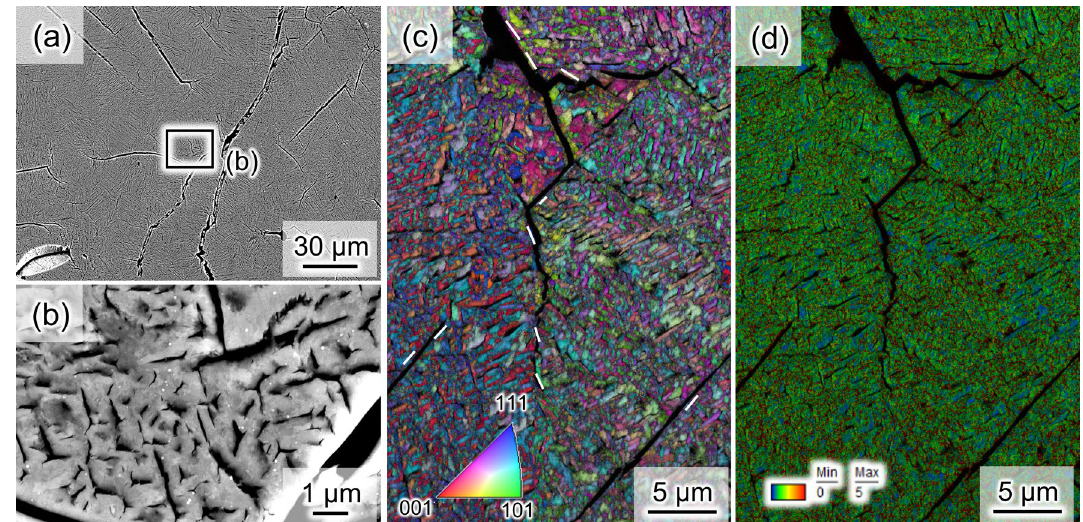
Figure 3. ( a , b ) Secondary electron images, ( c ) IPF map (bcc phase), and ( d ) KAM map that show the microstructure and numerous cracks in the hydrogenated specimen after depressurization. The white lines in ( c ) indicate some examples of {110} bcc traces along the cracks. The IPF and KAM maps are overlapped with the image quality map.